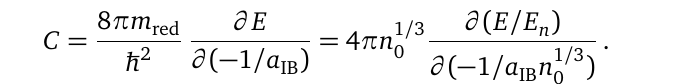
Figure 4: Tan contact C of the Bose polaron for different boson repulsion (BEC gas parameter) across the impurity-boson Feshbach resonance. The contact Cn tained from Eq. (15) reaches its maximum on the repulsive side of the resonance and increases for weaker boson repulsion. At weak coupling it approaches the mean-field result (16) (green